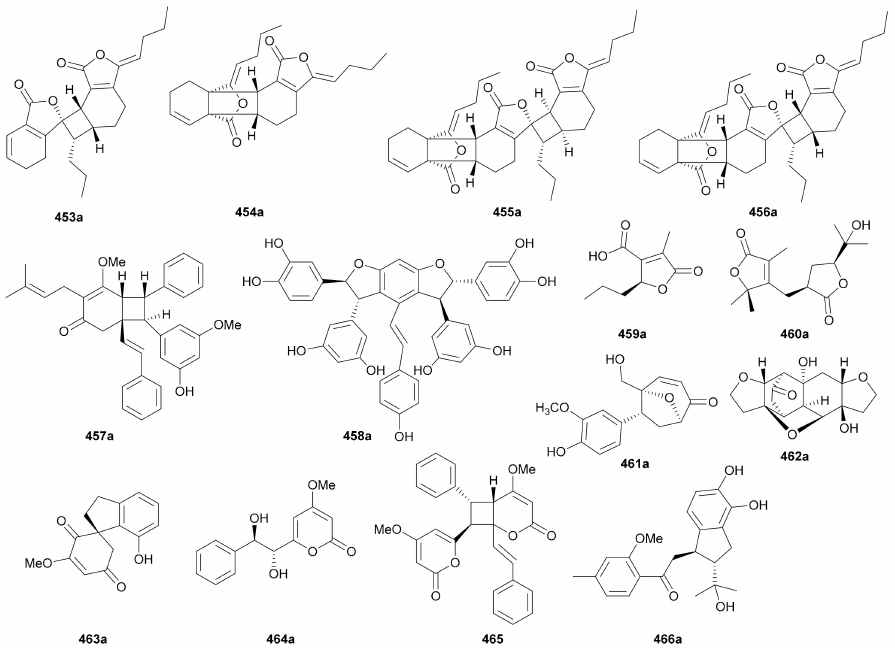
Figure 28. Structures of miscellaneous